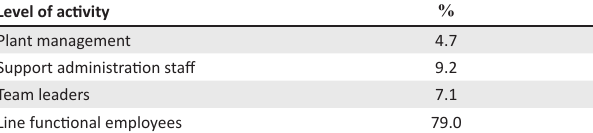
TABLE 1: Percentage breakdown of employees in terms of their level of